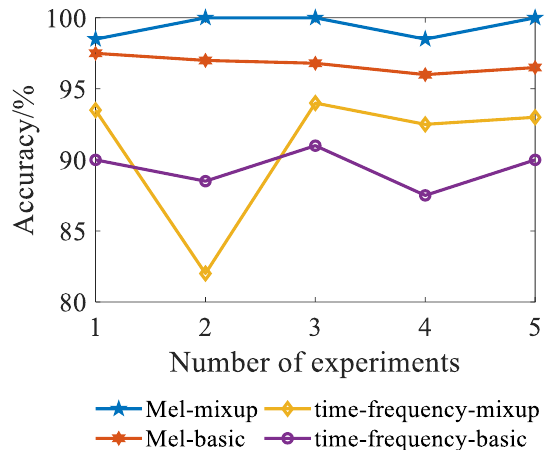
Figure 9. Comparison of diagnosis results of different